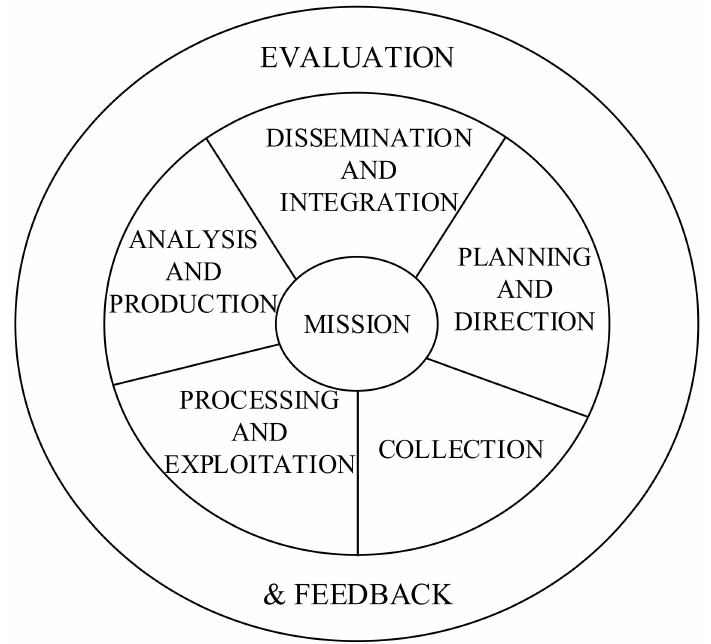
Figure 2. Process of providing operational